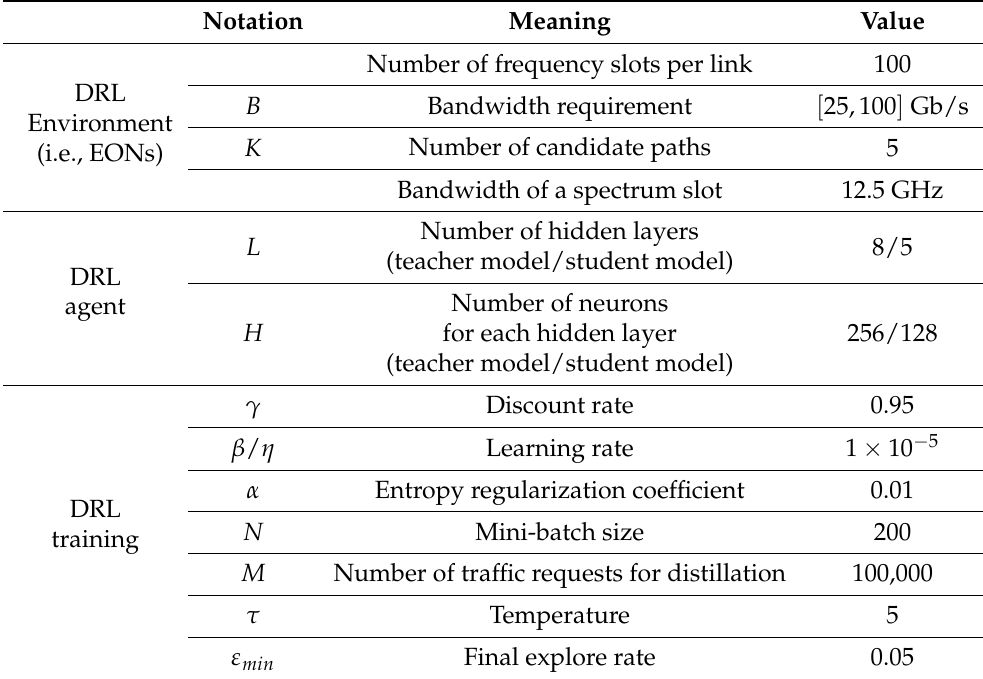
Table 2. Key parameters and their corresponding meaning and